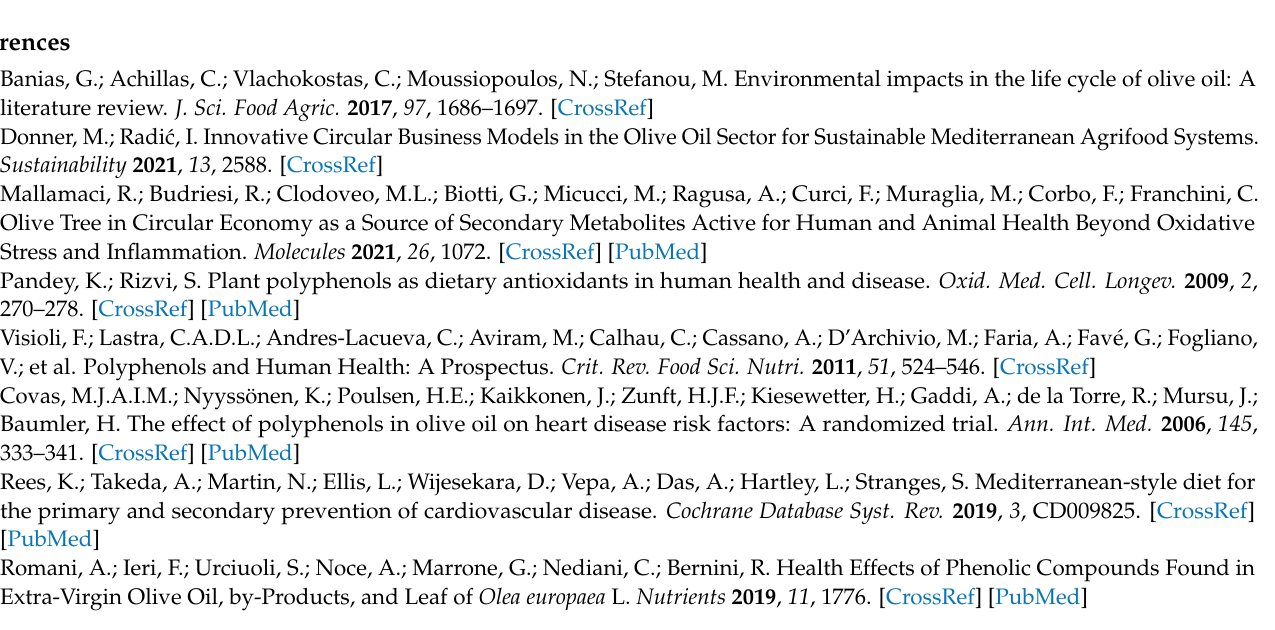
Table S1: product and lot number of antibodies